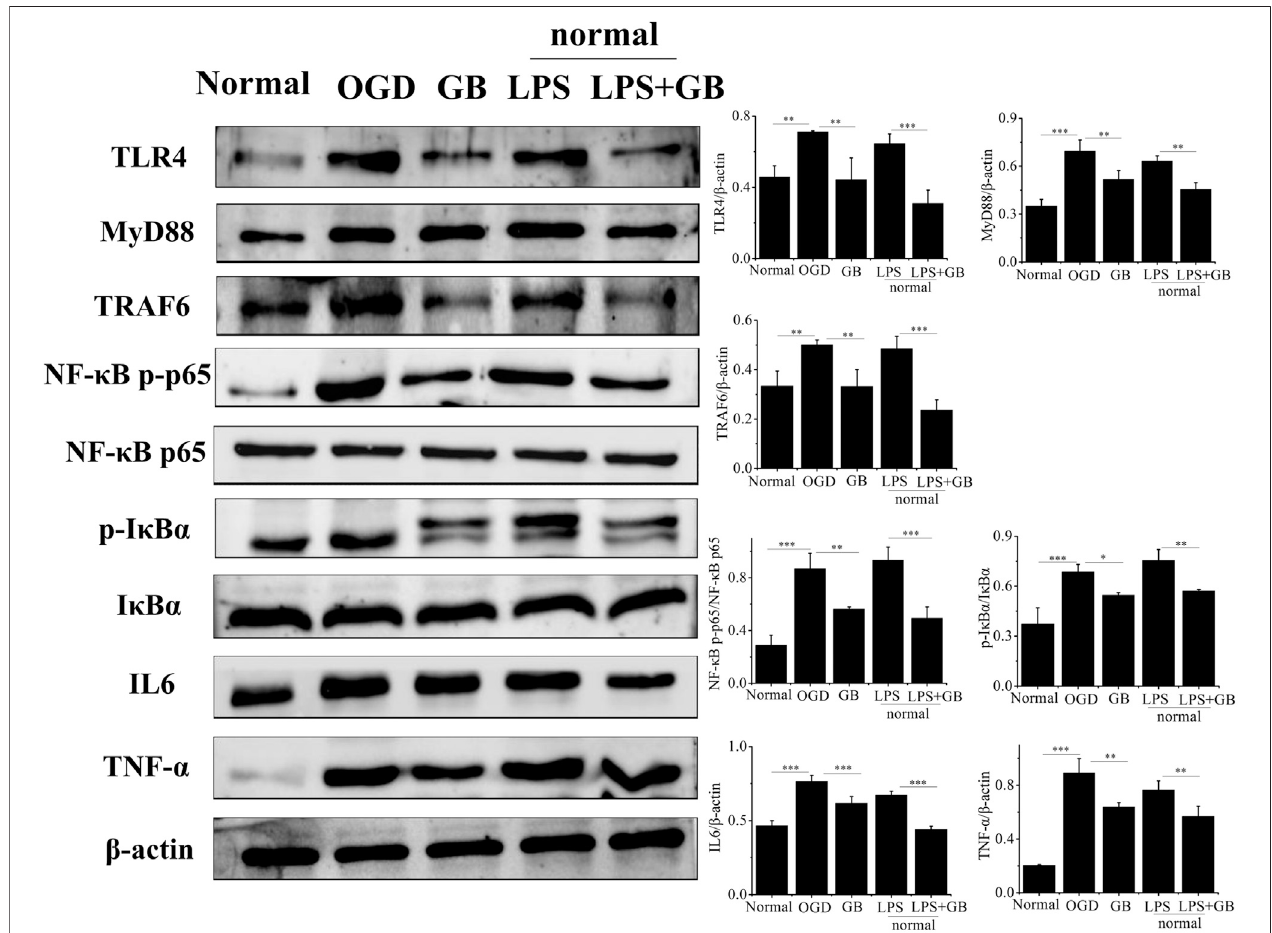
FIGURE3| DetectionoftheproteinlevelsofNF- κ Bp65,NF- κ Bp-p65,I κ B α ,p-I κ B α ,TLR4,MyD88,TRAF6,TNF- α andIL-6bywesternblotting.Datarepresented the mean ± SD ( n (cid:1) 3), * p < 0.05, ** p < 0.01, *** p < 0.001.